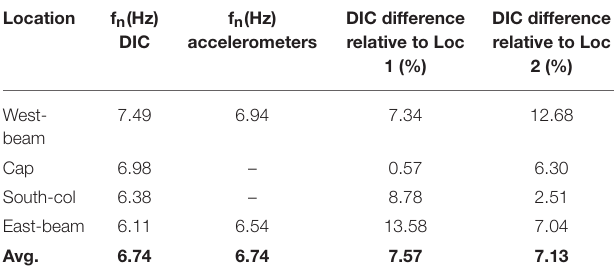
determined from both methods but can be defined using the SSI method as will be shown later.